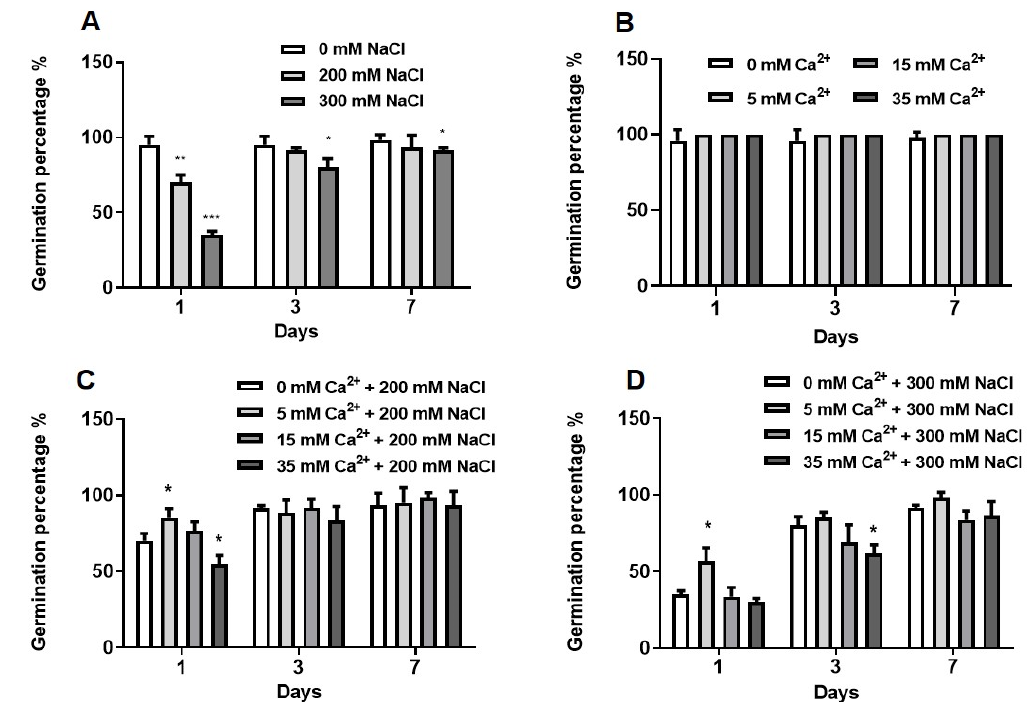
Figure 1. Effect of NaCl stress and Ca 2+ on the germination percentage of sorghum seedlings. ( A ) Seedlings germinated under different NaCl concentrations only. ( B – D ) Seedlings germinated under different NaCl and Ca 2+ (5, 15 and 35 mM) concentrations, ( B ) 0 mM, ( C ) 200 mM NaCl and ( D ) 300 mM NaCl. Error bars represent the SD calculated from three biological replicates. Statistical significance between control and treated plants was determined using two-way ANOVA conducted on GraphPad Prism 8.4.2, shown as *** = p ≤ 0.01, ** = p ≤ 0.01, and * = p ≤ 0.05 according to the Bonferroni’s multiple comparison test.